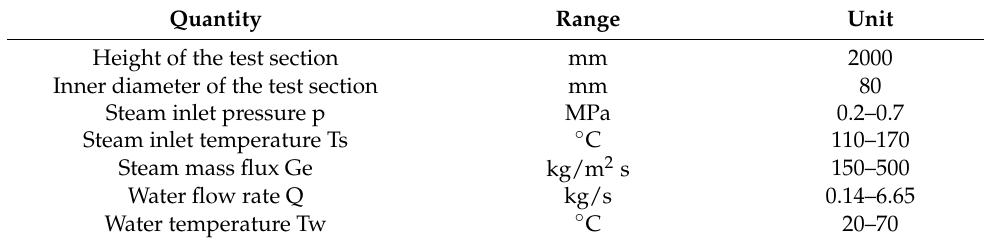
Table 13. The test conditions during experiments of Xu et al.